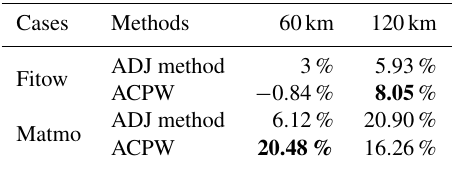
Table 6. Benefits (in %) gained from reducing the CNOPs by a fac- tor of 0.5 in the sensitive regions identified by the ADJ method and the ACPW algorithm with 20 points. The bold numbers represent the best values of the ACPW.